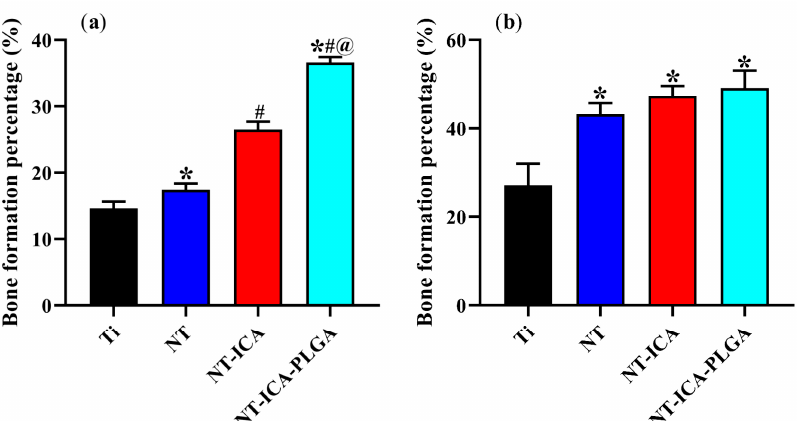
Figure 10. Histomorphometric analyses based on H&E staining after 2 and 4 weeks of implantation was expressed in BF %. ( a ) BF % after 2 weeks of implantation ( b ) BF % after 4 weeks of implantation. * indicate statistical significance compared to Ti, # indicate statistical significance compared to NT and @ indicate statistical significance compared to NT-ICA ( p < 0.05). Abbreviations: NT, TiO 2